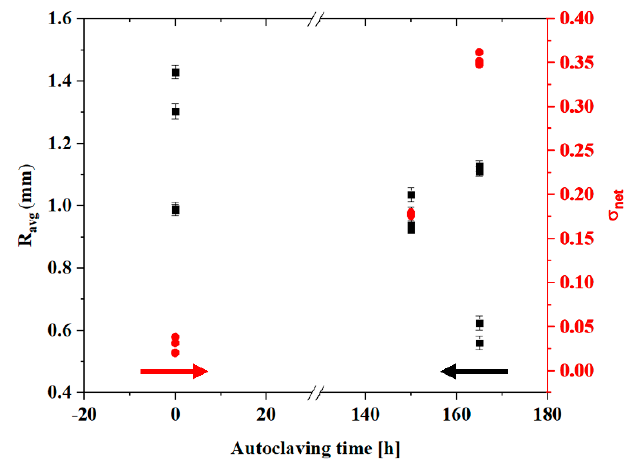
Figure 7. Radius of the mirror region and residual stresses as a function of the ageing conditions, for CoCr trunnions (red circles for σ , black squares for R avg ).